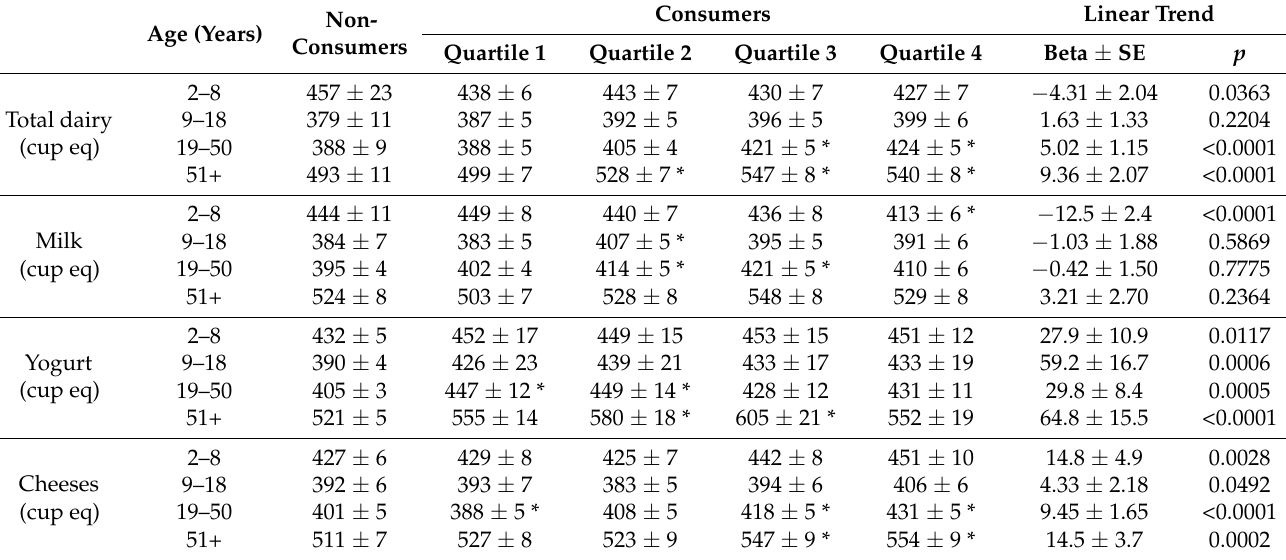
Table 2. RBC folate status (ng/mL RBC) by dairy intake in different age